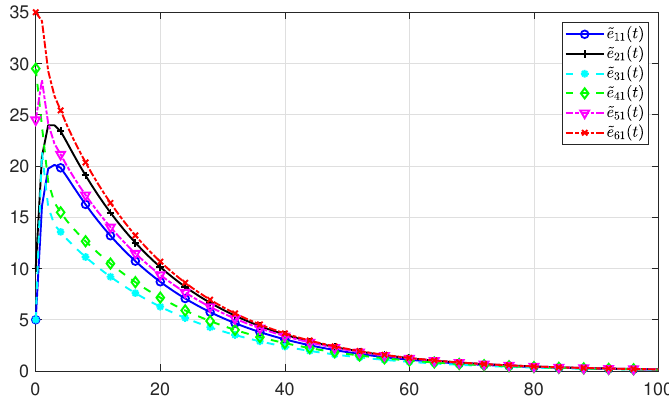
Figure 11. The simulations of ˜ e i 1 ( k ) of all the agents.